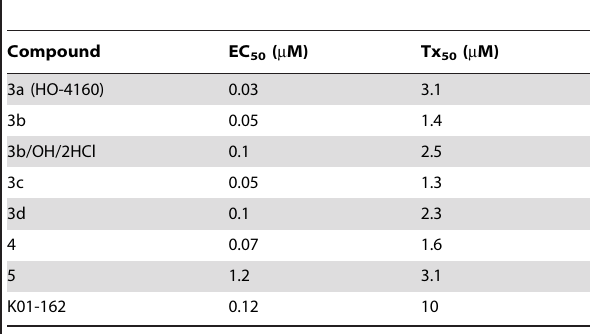
Table 1. Potency of SLF compounds [15] against A b toxicity as determined by the MTT